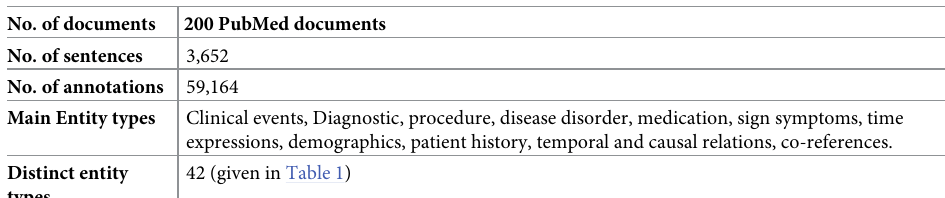
Table 2. Dataset